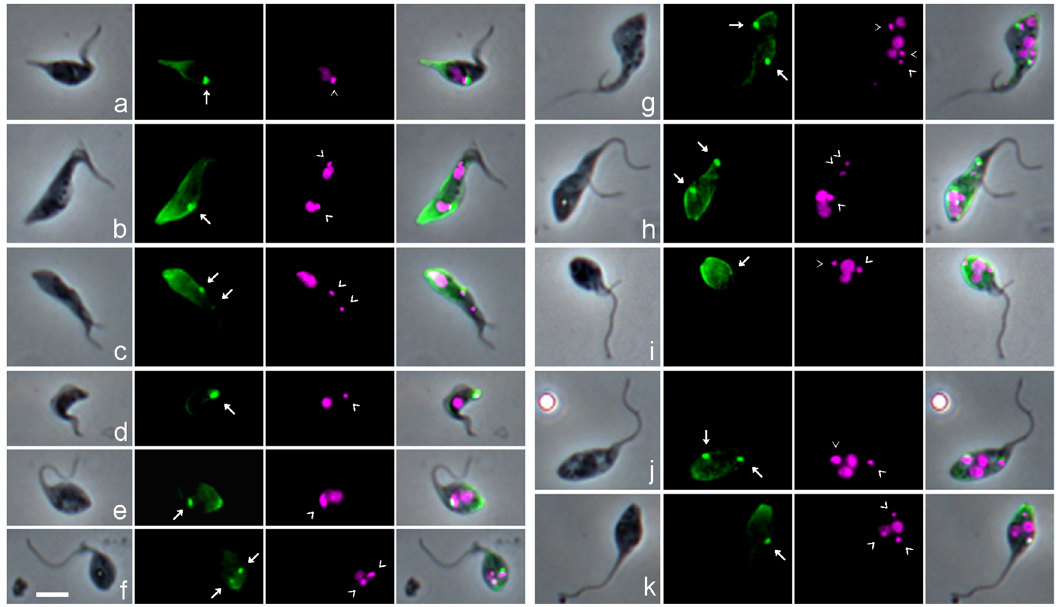
Fig. 2 Identi fi cation of the basal body using YL1/2 antibody against tyrosinated α -tubulin. T. b. brucei 1738 wild-type trypanosomes derived from tsetse salivary glands were fi xed and stained with YL1/2 antibody against tyrosinated α -tubulin visualized with FITC secondary antibody; the basal bodies (BBs) shown as bright green fl uorescent dots, with additional staining of the plus ends of newly formed microtubules at the posterior of the cell. L to R: phase contrast, YL1/2 (green FITC fl uorescence), DAPI (false coloured magenta fl uorescence), merge all. BBs are indicated by white arrows (YL1/2 images) and kinetoplasts (K) by arrowheads (DAPI images). a 1K1N epimastigote with prominent posterior nozzle ; b 2K2N dividing epimastigote; c 2K1N meiotic divider, with just visible anterior BB; d 1K1N metacyclic; e 1K1N gamete; f 2K1N gamete. g – k various meiotic intermediates with multiple K and/or N: g 3K3N cell with two fl agella; h 3K2N cell with two fl agella; i 2K2N cell with two fl agella; j 2K2N, single fl agellum; k 3K2N, single fl agellum. Scale bar = 5 µ